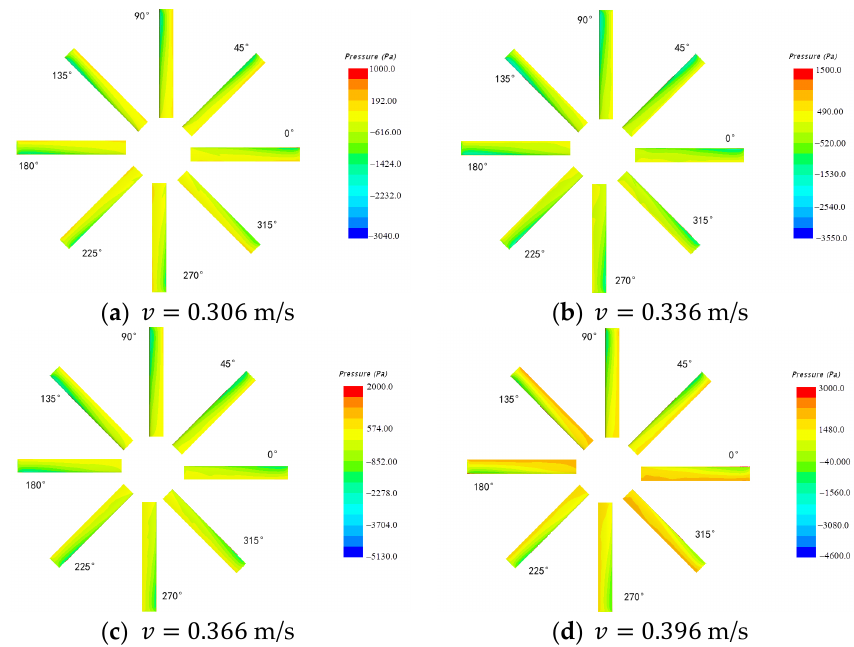
Figure 17. Pressure distribution on blade upper surface.